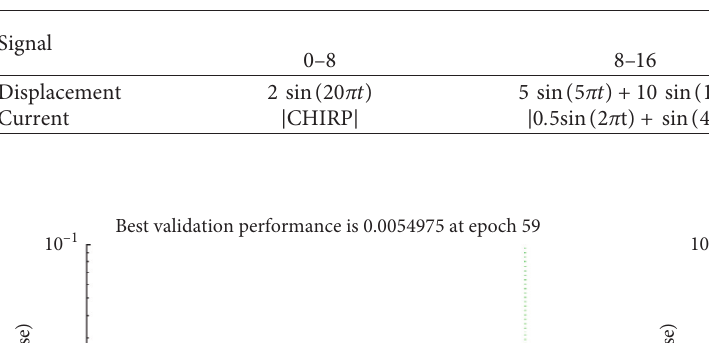
Table 1: Modeling data of neural network.